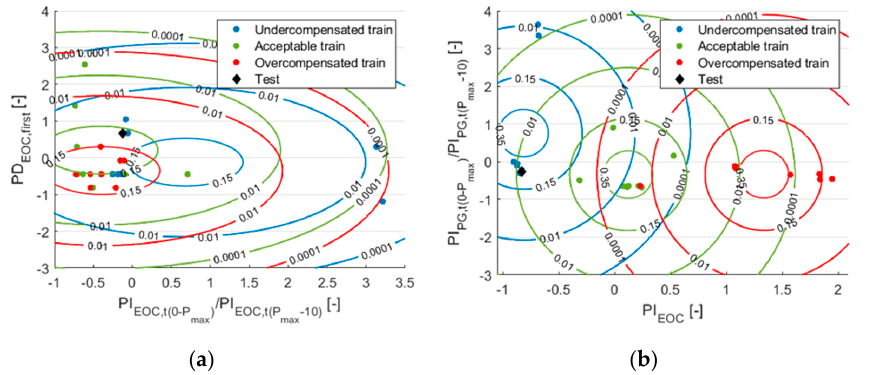
Figure 12. Training data and test data (from the uncompensated class) with distributions presented in two different dimension planes: ( a ) in two “worse” dimensions; ( b ) in the two “best” dimensions selected by the SFS method. Note that we used eight training samples per class.